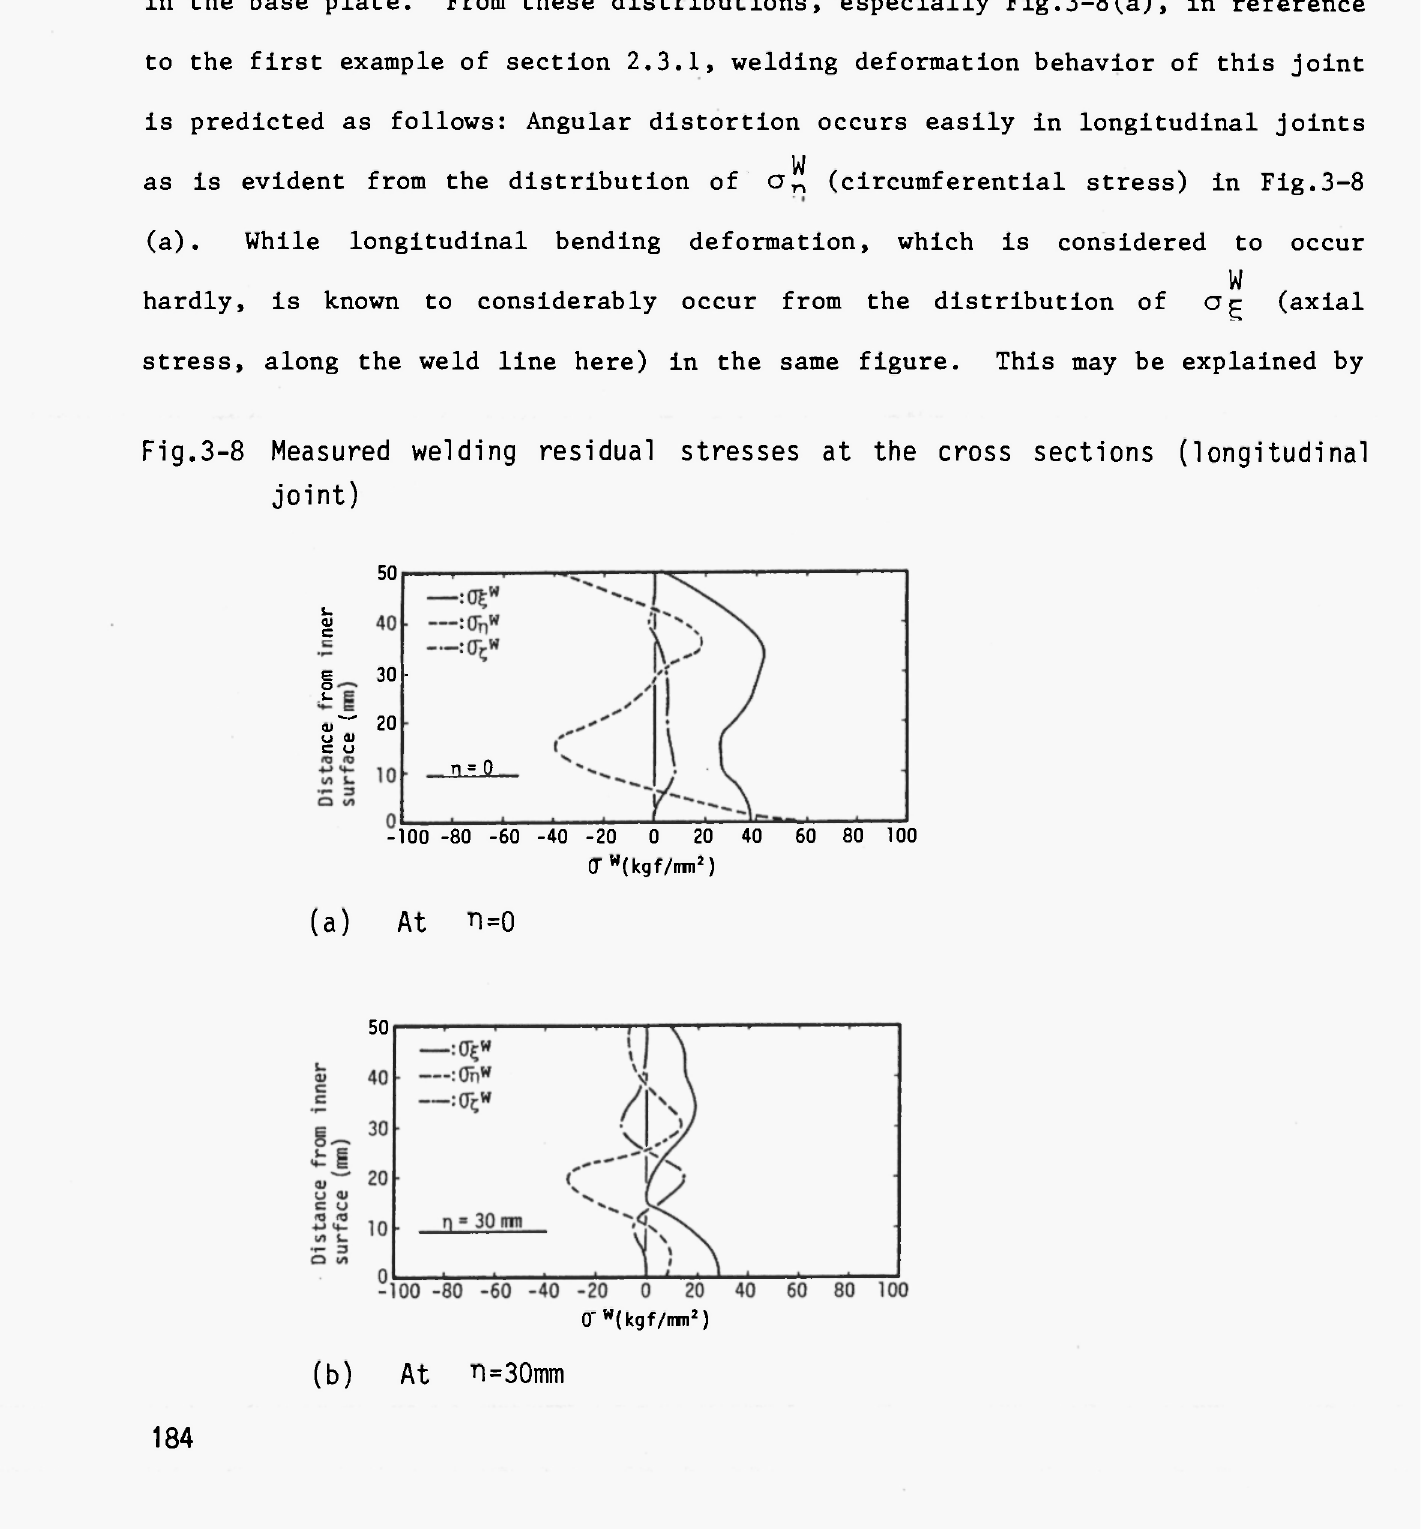
Measured welding residual stresses at the cross